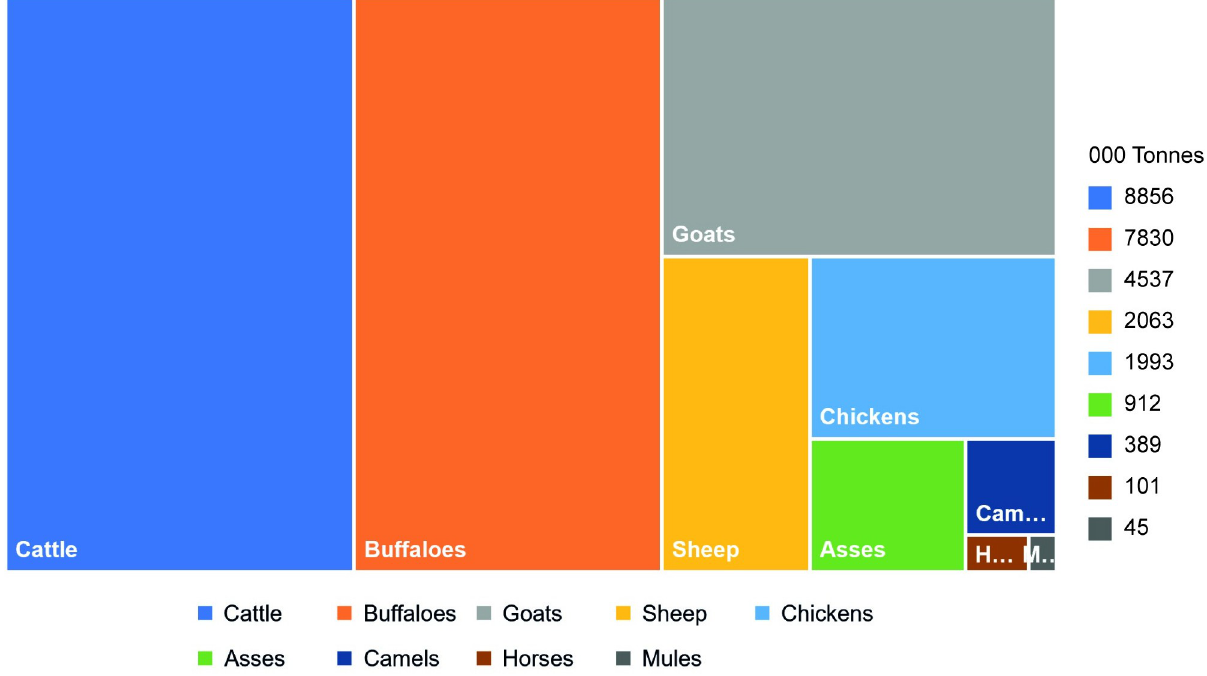
Fig 4. Average biomass of different animal species likely to be treated with antimicrobials for the years 2017–19.